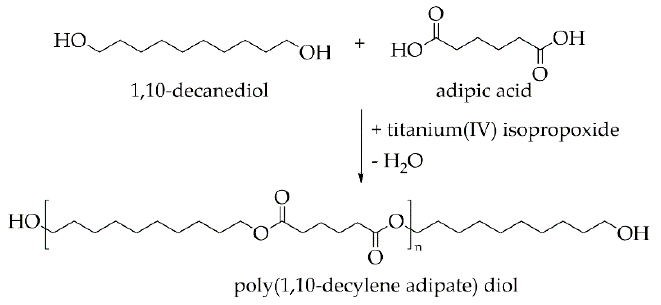
Figure 1. Synthesis of poly(1,10-decylene adipate) diol via polycondensation reaction.